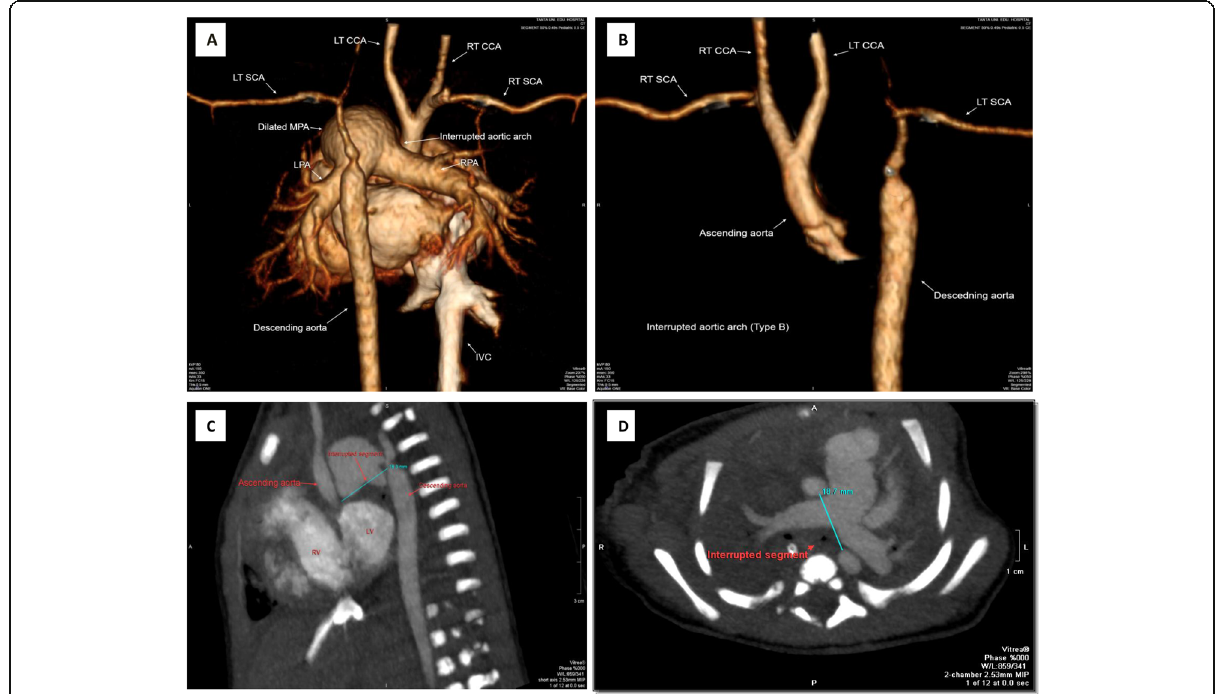
Fig. 3 A case of interrupted aortic arch type B aged 2 days presented with failure to thrive. a Volume rendered image of the heart and great vessels with interruption of aortic arch distal to left common carotid artery, descending aorta arising from a small PDA connecting it to main pulmonary trunk with focal coarctation at ductal site. b Volume rendered image of thoracic aorta with type B interruption. c Sagittal MIP image showing length of interrupted segment of aortic arch. d Axial MIP image showing length of interrupted segment of aortic